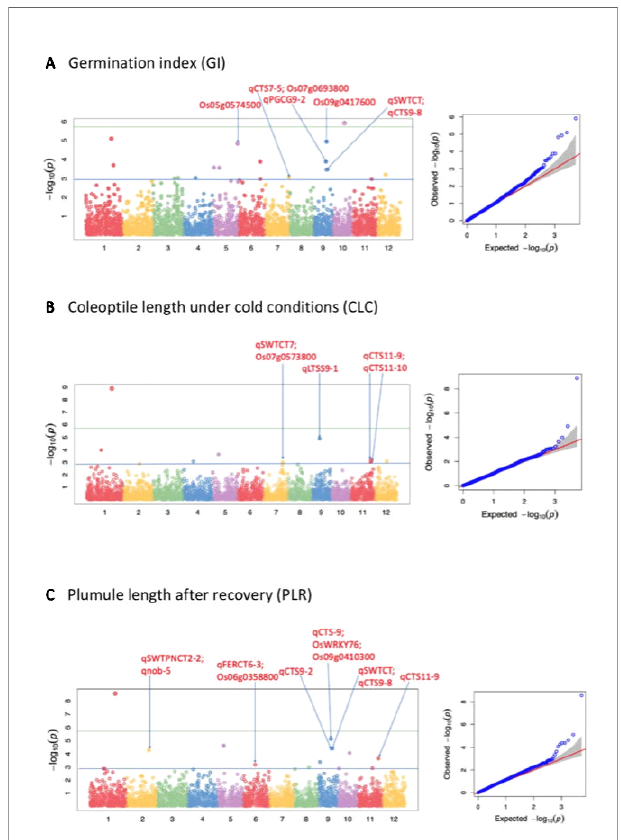
FIGURE 2 | Selected Manhattan and QQ plots of the whole panel for germination index (GI), shoot length under cold (CLC), and plumule length recovery (PLR). The solid blue line shows the p-value 0.001 signi fi cant threshold; while the solid green line shows the Bonferroni